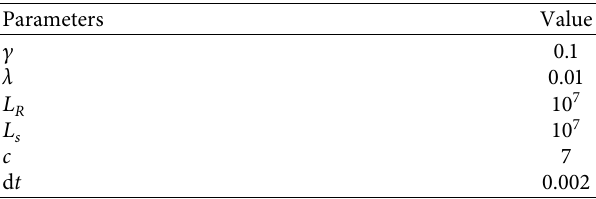
Table 5: Parameters for obtaining K and simulation for τ � 0 . 1s and stochastic disturbance.